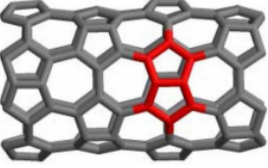
Figure 6. Molecular graph of VC 5 C 7 [ p , q ] .